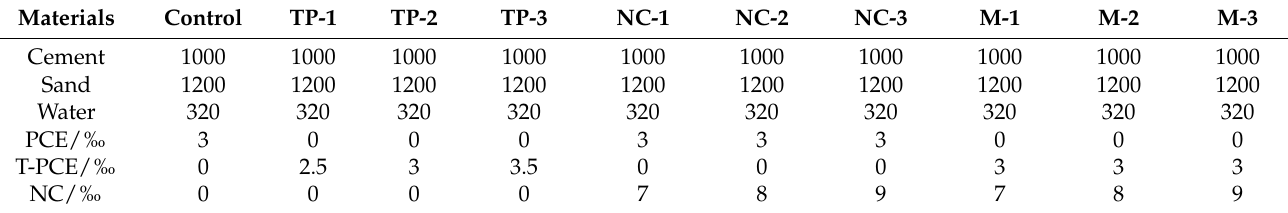
Table 2. Mix design of 3D printing concrete (kg/m 3